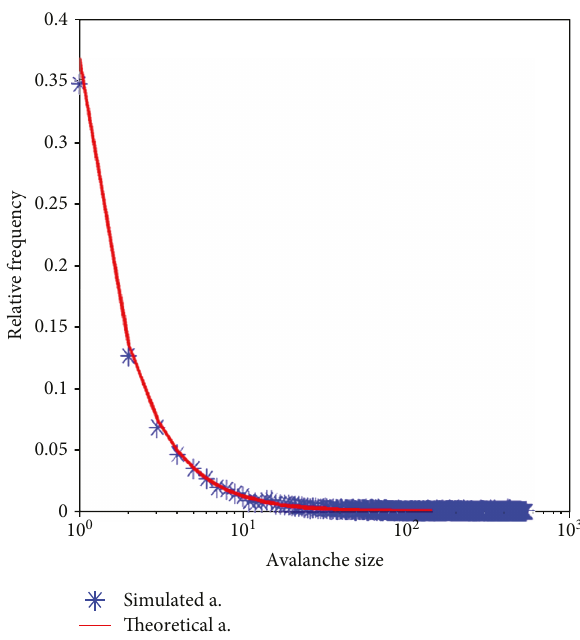
Figure 1: Theoretical avalanche distribution (red line), as given by (3), together with the distribution observed in simulations (blue stars) from RBNs with 1000 nodes, 2 inputs per node, and all 16 Boolean function